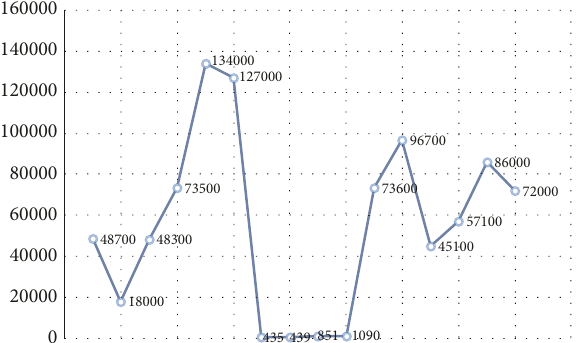
Figure 3: Comparison between IgE levels during application of omalizumab. The y-axis: serum IgE expressed in IU/ml; the x-axis: the dates on which these levels were taken. The decrease in IgE levels was clearly observed during the application of omalizumab; these increased after treatment was